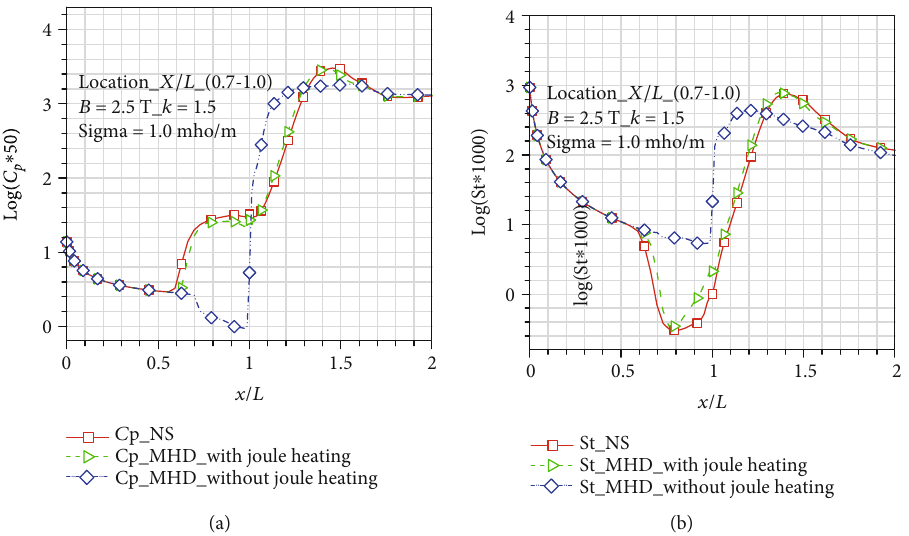
Figure 11: E ff ect of the Joule heating on the wall pressure and wall heat transfer distribution: (a) wall pressure distribution; (b) wall heat transfer distribution.